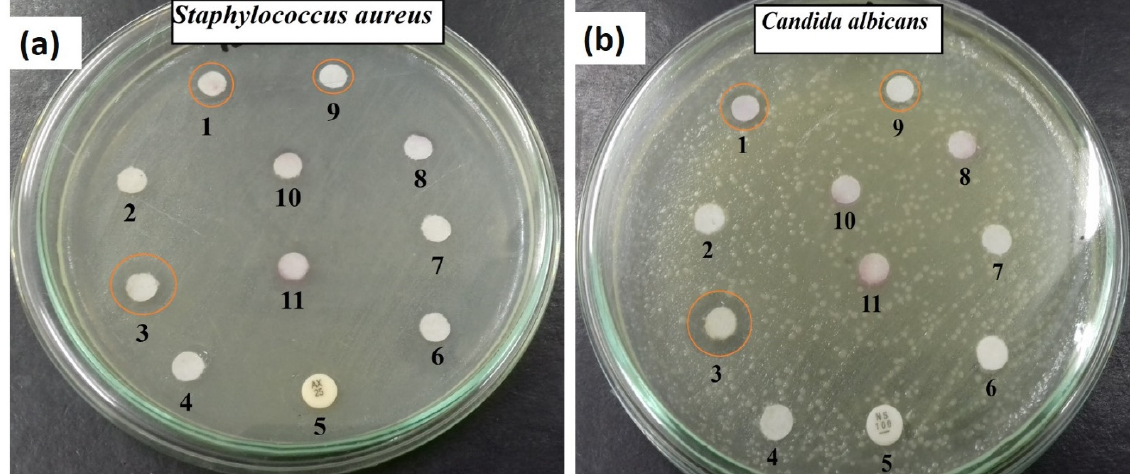
Figure 7. Antimicrobial activities and ZOI (mm) of tested ferrites (ZnCe x Fe 2 − x O 4 ) against the pathogenic microbes Staphylococcus aureus ( a ) and Candida albicans ( b ), where (1) X = 0.08, (2) X = 0.02, (3) X = 0.06, (4) X = 0.00, (5) standard positive control as amoxicillin (AX), and nystatin (NS), (6) DMSO (negative control), (7) Fe(NO 2 ) 3 ·9H 2 O, (8) ZnSO 4 .7H 2 O, (9) X = 0.04, (10) Ce(NO 3 ) 3 .6H 2 O, and (11) Eb; circle indicating the presence of ZOI.